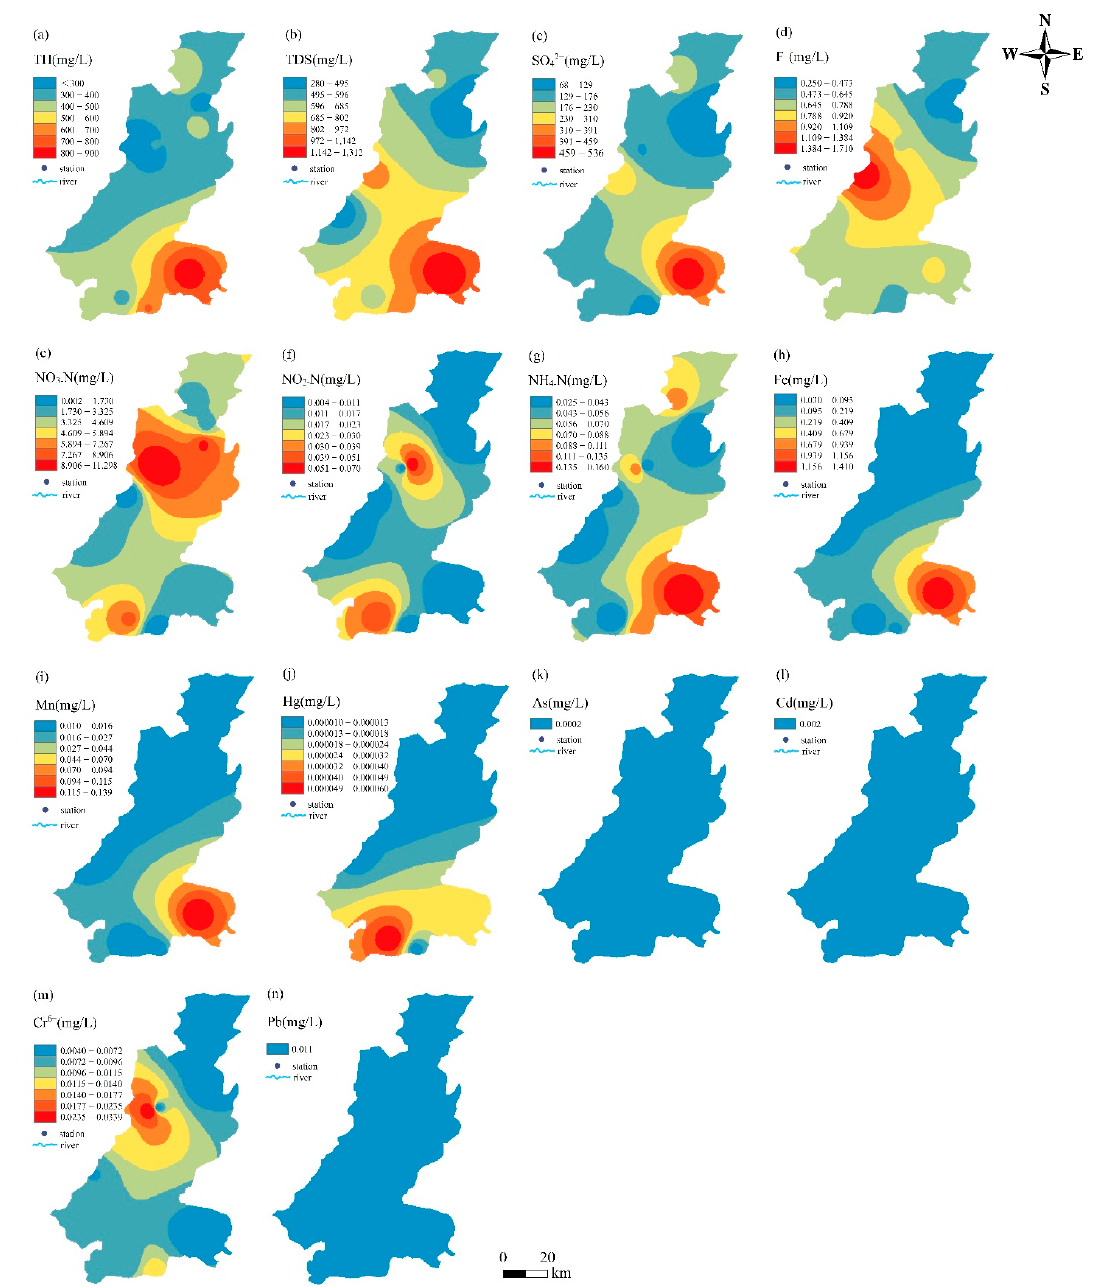
Figure 2. Spatial distributions of mass concentrations of groundwater hydrochemical parameters: ( a ) TH, ( b ) TDS, ( c ) SO 42 − , ( d ) F − , ( e ) NO 3 -N, ( f ) NO 2 -N, ( g ) NH 4 -N, ( h ) Fe, ( i ) Mn, ( j ) Hg, ( k ) As, ( l ) Cd, ( m ) Cr 6+ , and ( n ) Pb.